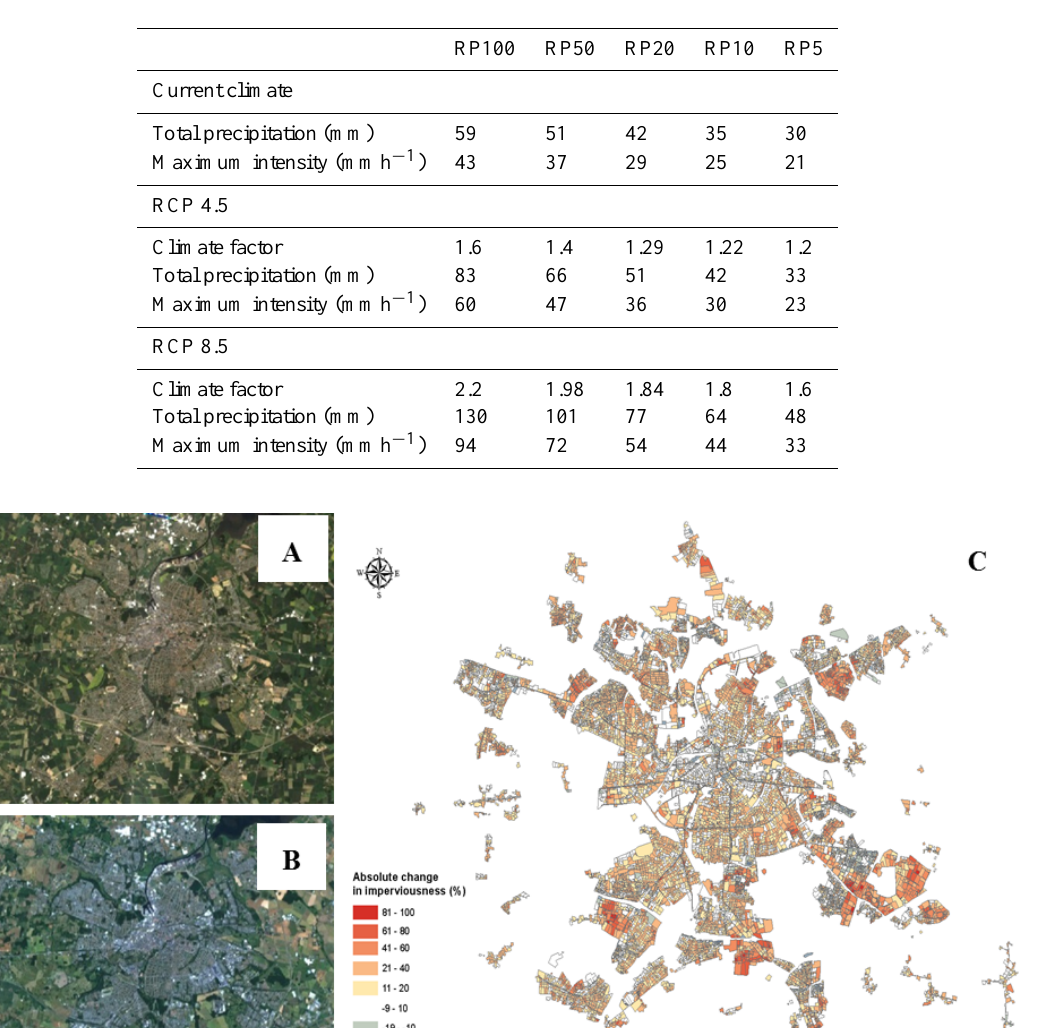
Table 1. Design intensities and climate factors for extreme precipitation in Odense under current and future climate, RP5 = return period of 5 years. CF’s for RCP4.5 from Gregersen et al. (2014) and RCP 8.5 from Arnbjerg-Nielsen et al. (2015).